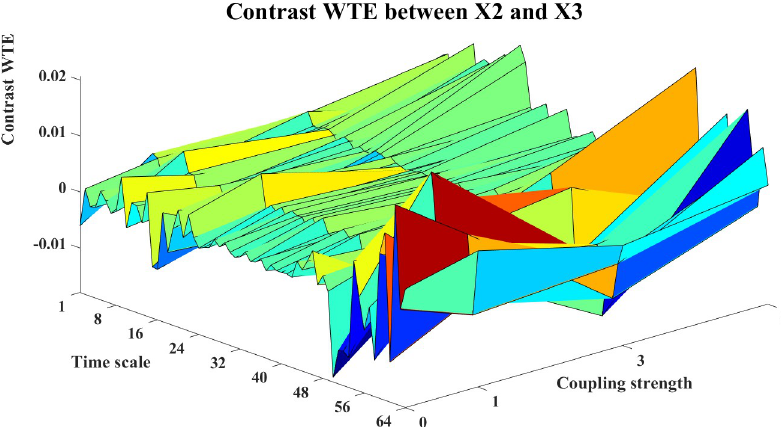
Fig 24. The contrast WTE information transfer for X2 ! X3. The 3D surface presents the contrast WTE (